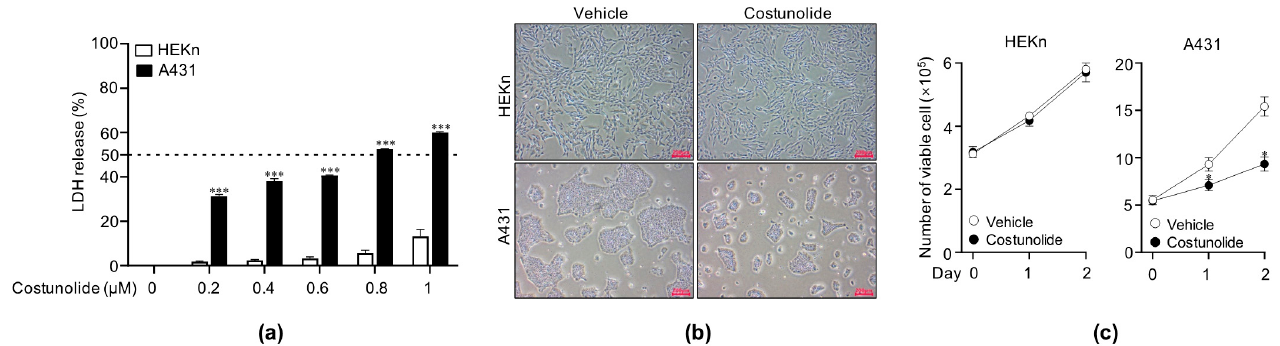
Figure 1. Effect of costunolide on cell viability in HEKn cells and A431 cells. ( a ) Cell viability was measured using the LDH assay kit. Cells were cultured at the indicated concentrations of costunolide for 48 h, following which the supernatants were collected and analyzed. Cells treated with lysis buffer was used as a positive control (100% LDH release). ( b ) Cell growth was detected by microscopic examination. Cells were cultured in the presence/absence of costunolide (0.8 µM) for 48 h. Representative images are shown. Scale bar = 200 µm ( c ) Cell viability was measured using trypan blue exclusion assay. Cells were cultured in the presence/absence of costunolide (0.8 µM) for 48 h. After harvesting and re-suspending, cells were stained with trypan blue solution. The viable cell numbers were counted using a hemocytometer on days 0, 1, and 2. * p < 0.05 and *** p < 0.001 as compared to vehicle-treated group.